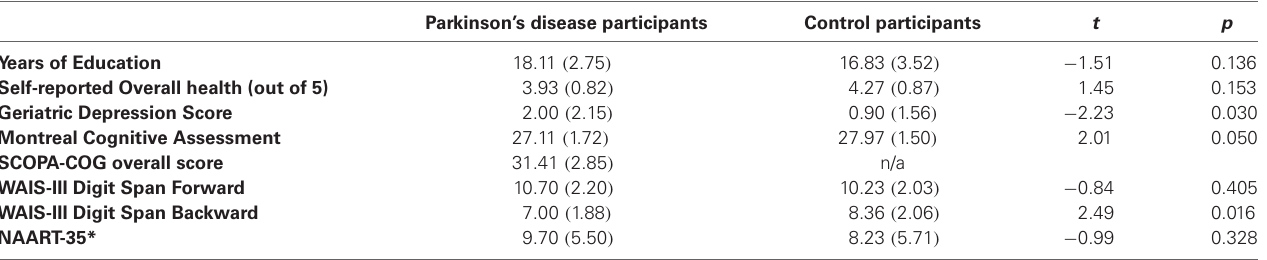
Table 1 | Parkinson’s disease and healthy control participant